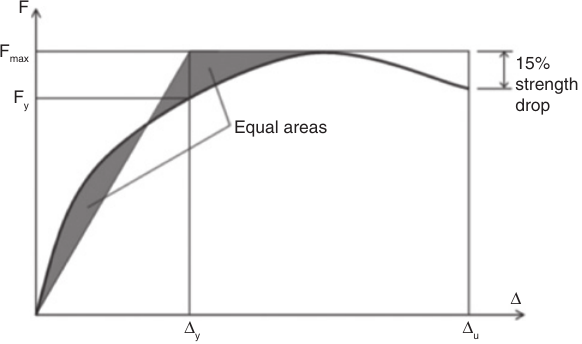
Figure 10: Determination of yield and ultimate displacements according to criteria for equivalent elastoplastic energy